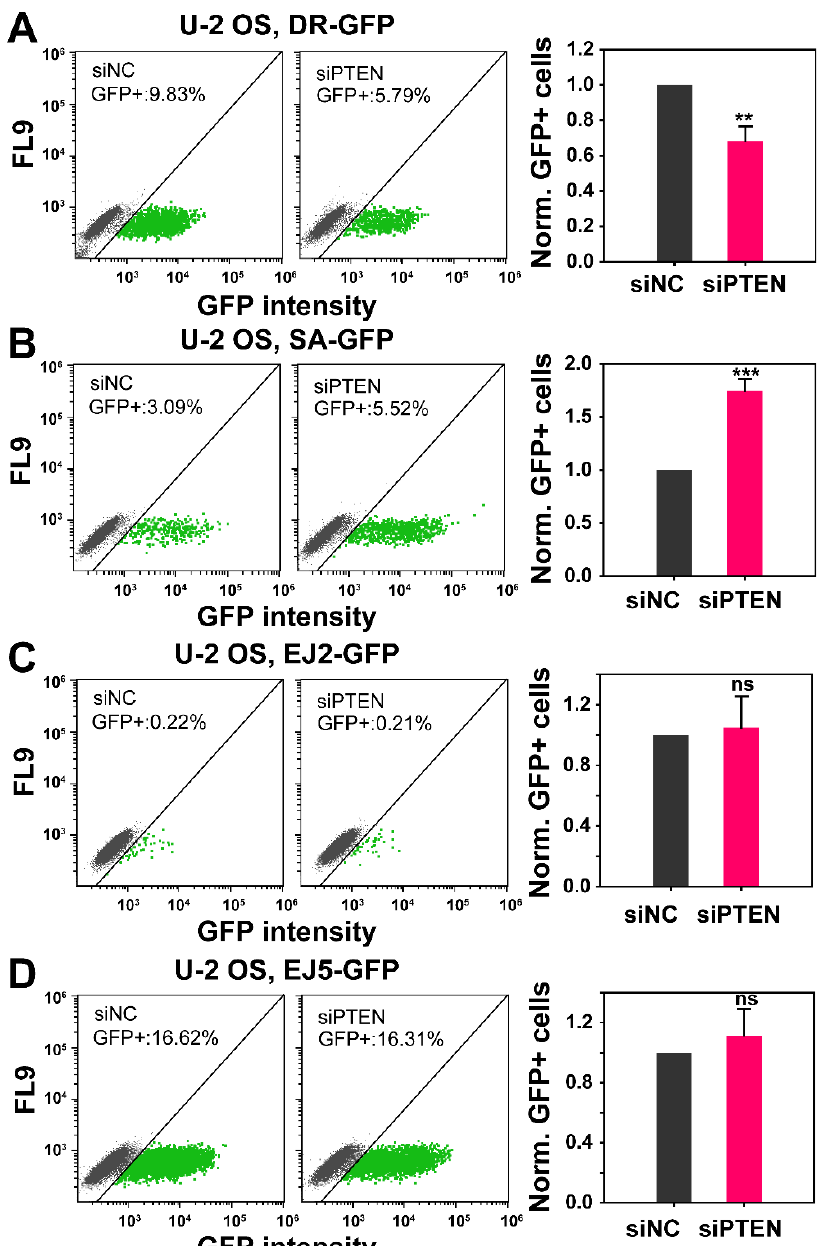
Figure 2. Effect of PTEN deficiency on HR, SSA, NHEJ and alt-EJ. The established GFP-reporter assays in U-2 OS cells, specifically designed to report the repair of I- SceI -induced DSBs by HR (DR-GFP), SSA (SA-GFP), NHEJ (EJ5-GFP) and alt-EJ (EJ2-GFP) were utilized. ( A ) Percentage of GFP positive cells (GFP+), in the negative control (siNC) and PTEN knock-down (siPTEN) of DR-GFP cells. Bar plots (right panel) reflect the siNC-normalized GFP+ cells. ( B ) Same as panel ( A ), but for SA-GFP cells. ( C ) Same as panel ( A ), but for EJ5-GFP cells. ( D ) Same as panel ( A ), but for EJ2-GFP cells. Data represent the mean ± SD from three independent experiments. The significance level, or p -value, is calculated using the two-tailed, Student´s t -test: ns (not significant), * p < 0.05, ** p < 0.01, *** p < 0.001.